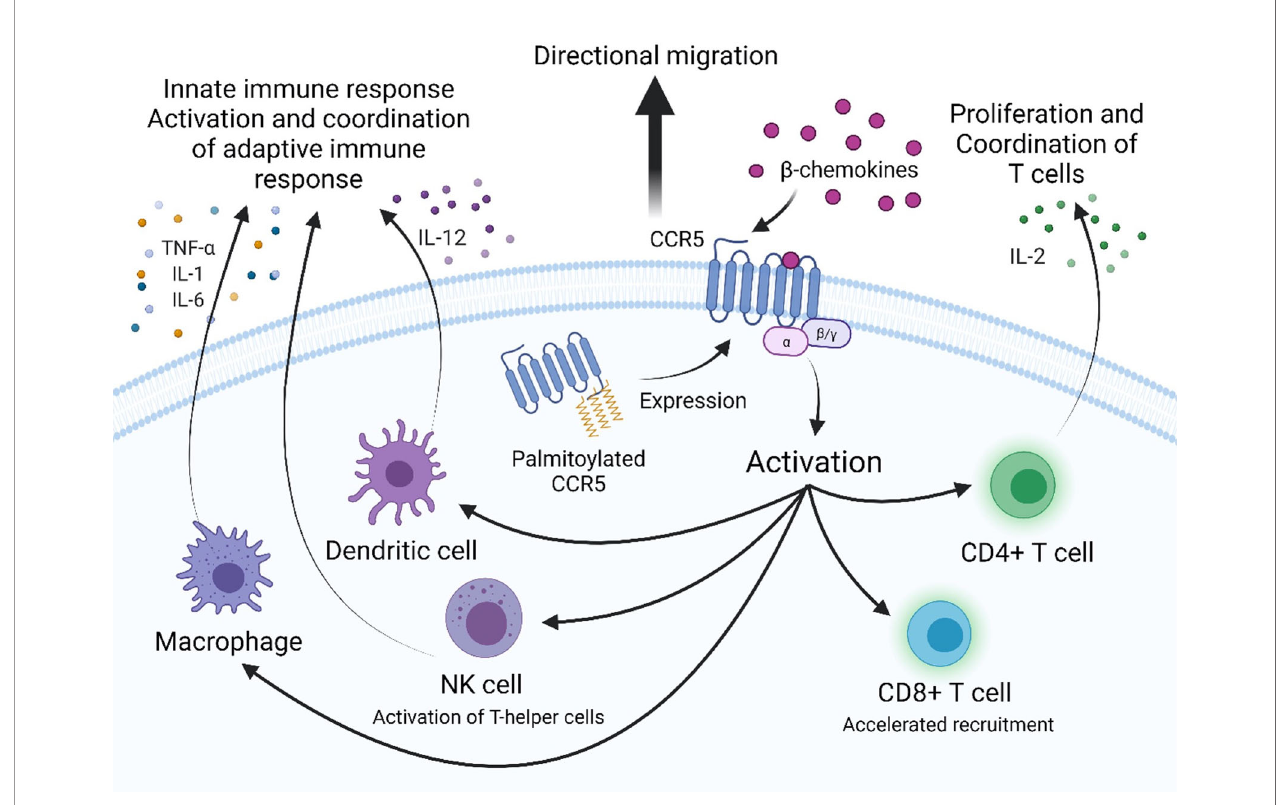
FIGURE 1 | CCR5 is a G-protein coupled receptor that is involved in activation and coordination of the innate and adaptive immune response. Palmitoylation of multiple cysteine residues in the C-terminal domain target CCR5 to lipid rafts in the plasma membrane to participate in extracellular signaling. b -chemokines bind to extracellular domains of CCR5, activating it and inducing downstream signaling. CCR5 expression is required for directional migration and coordination of cells of the innate and adaptive immune response along a chemotactic gradient to sites of infection. CCR5-dependent secretion of pro-in fl ammatory cytokines by macrophages (TNF- a , IL-1, and IL-6) and dendritic cells (IL-12) activate the adaptive immune response. CCR5-dependent secretion of IL-2 by activated CD4+ T cells induces proliferation and activation of effector, memory and regulatory T cells. CCR5 is required for the accelerated recruitment of effector and memory CD8+ T cells to sites of